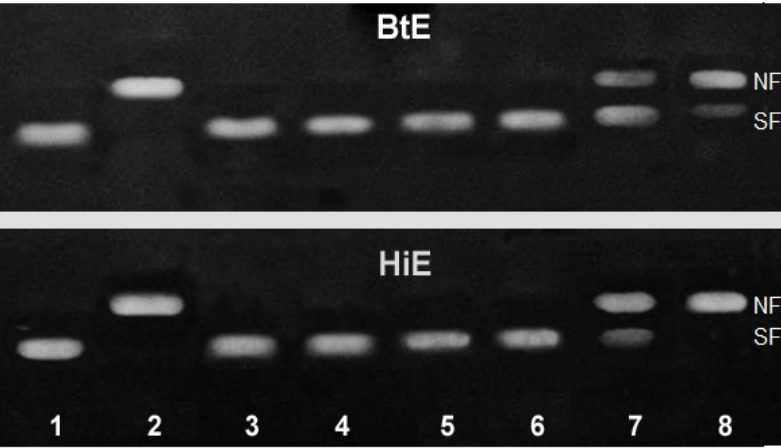
Figure 1. Clastogenic effect of different concentrations of B. triquetrum and H. incrassata extracts on plasmid DNA during 30 min: (1) Negative control; (2) Positive control; (3–8) DNA exposed to 0.01, 0.1, 0.5, 1.0, 2.0 and 4.0 mg/mL of seaweed extracts. SF: supercoiled form. NF: open nicked